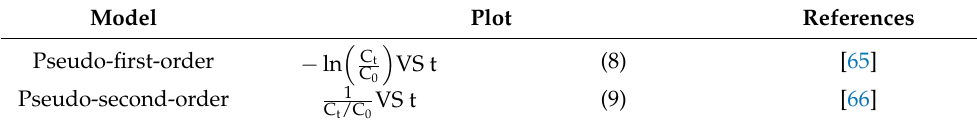
Table 6. The equation of